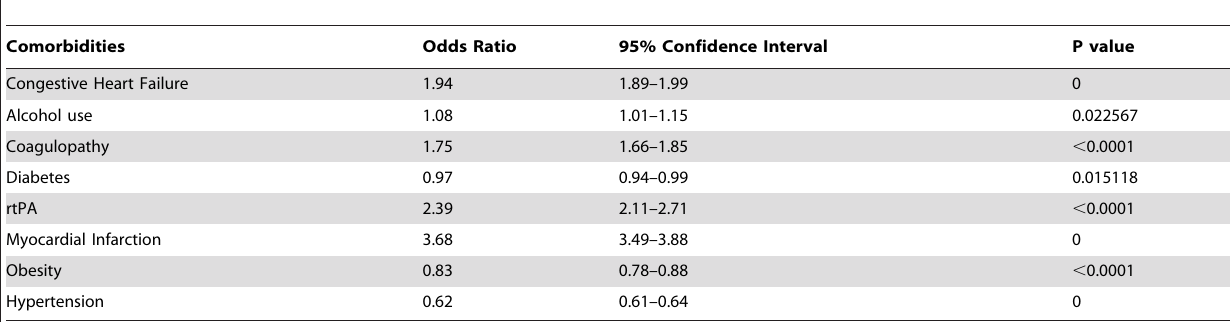
Table 5. Multivariate analysis predicting the odds of